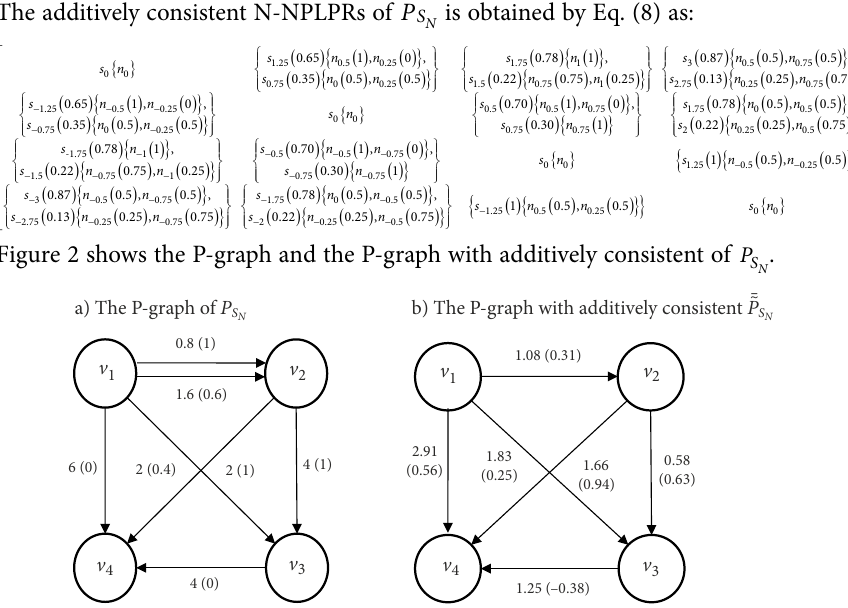
P and P-graph with additively consistent of N S (sources: authors’ own